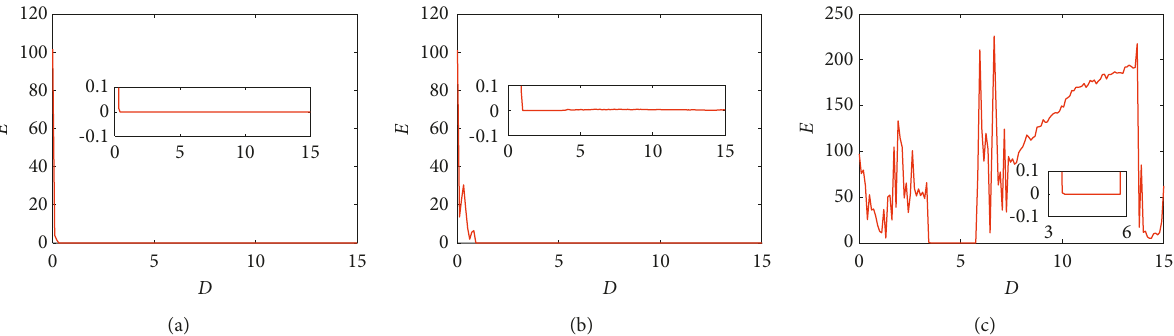
Figure 9: The synchronization errors of the coupled model with respect to coupling strength at case 2 (bursting and quiescent neurons). For (a) τ � 0 . 01; (b) τ � 0 . 5; and (c) τ � 3. Partially enlarged interval for partial synchronization, and the initial values are selected with (0.1, 0.01, 1.05, 0.1, 0.01, 1.05).